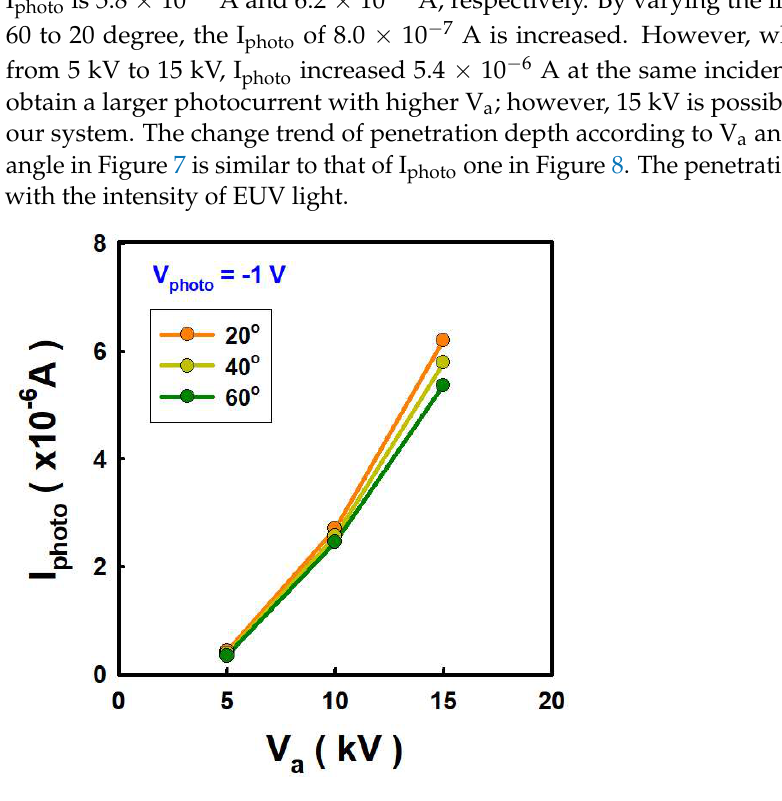
Figure 8. Photocurrent at reverse bias voltage of −1 V with different anode voltage and electron incident angle. incident